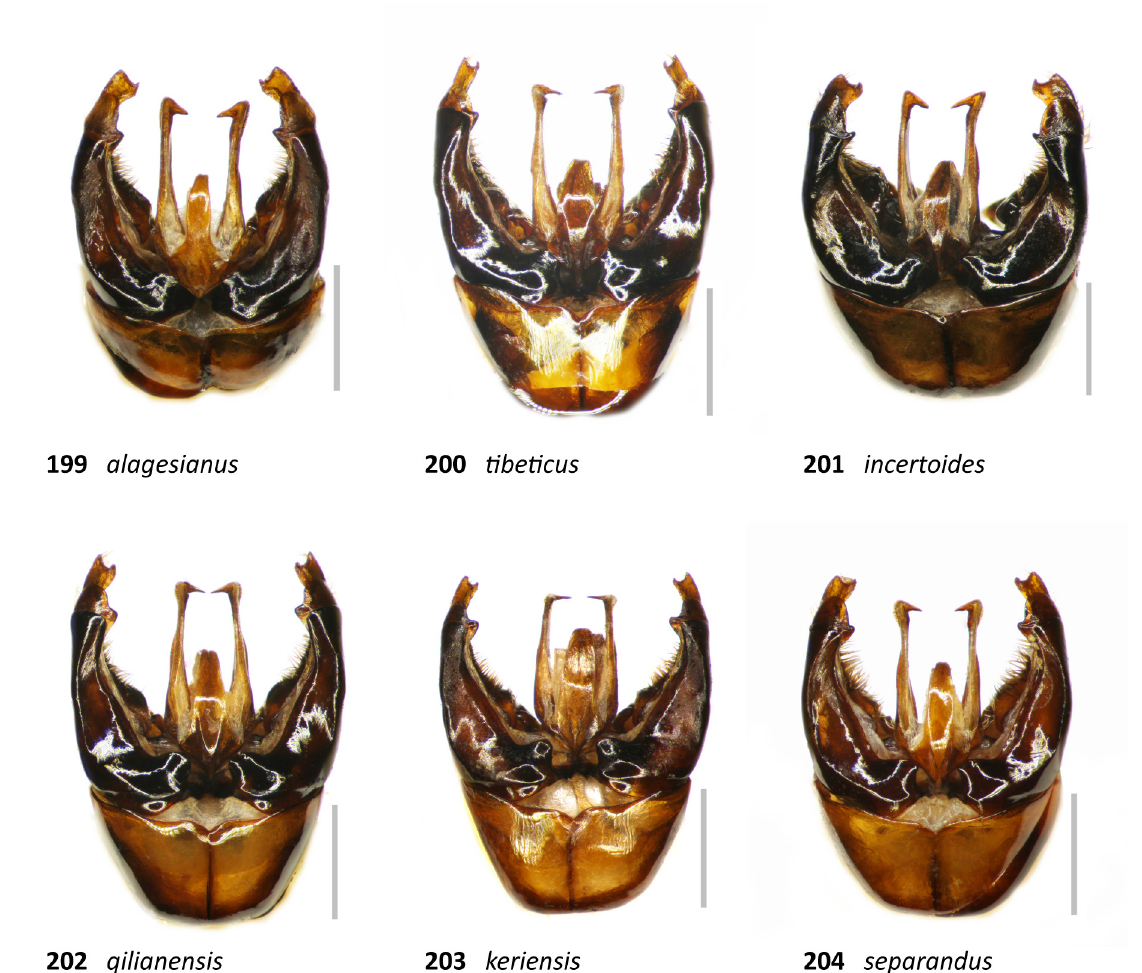
Figs 199‒204. Morphology of the male genitalia for species of the subgenus Melanobombus von Dalla Torre, 1880 from the dorsal aspect, anterior at the bottom of the image, posterior at the top. 199 .